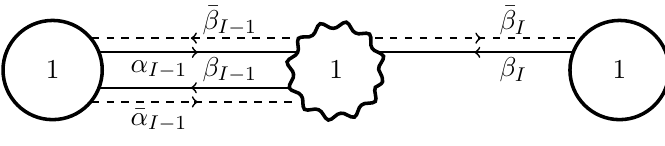
Figure 6 . A quiver diagram for a 1 / 16 BPS Wilson loop.